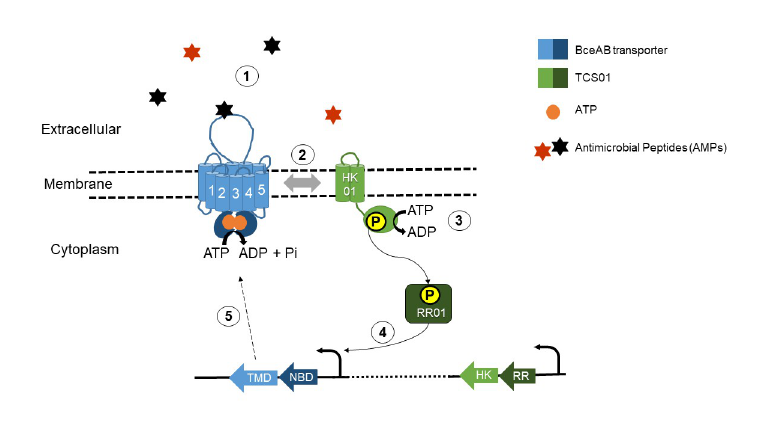
Fig 8. Functional module involving TCS01 in Streptococcus pneumoniae . The BceAB/TCS01 module is able to sense the presence of antimicrobial peptides targeting undecaprenylpyrophosphate (UPP) or lipid II (step 1). The AMPs presumably bind to the extracellular domain of BceAB and stimulate the ATPase or GTPase activity of the transporter, triggering or enhancing the phosphorylation of TCS01 (steps 2 and 3). Consequently, the RR upregulates the operon containing the bceAB genes but does not regulate the tcs01 operon (step 4). The overexpression of BceAB mediates antimicrobial peptide resistance (step 5).